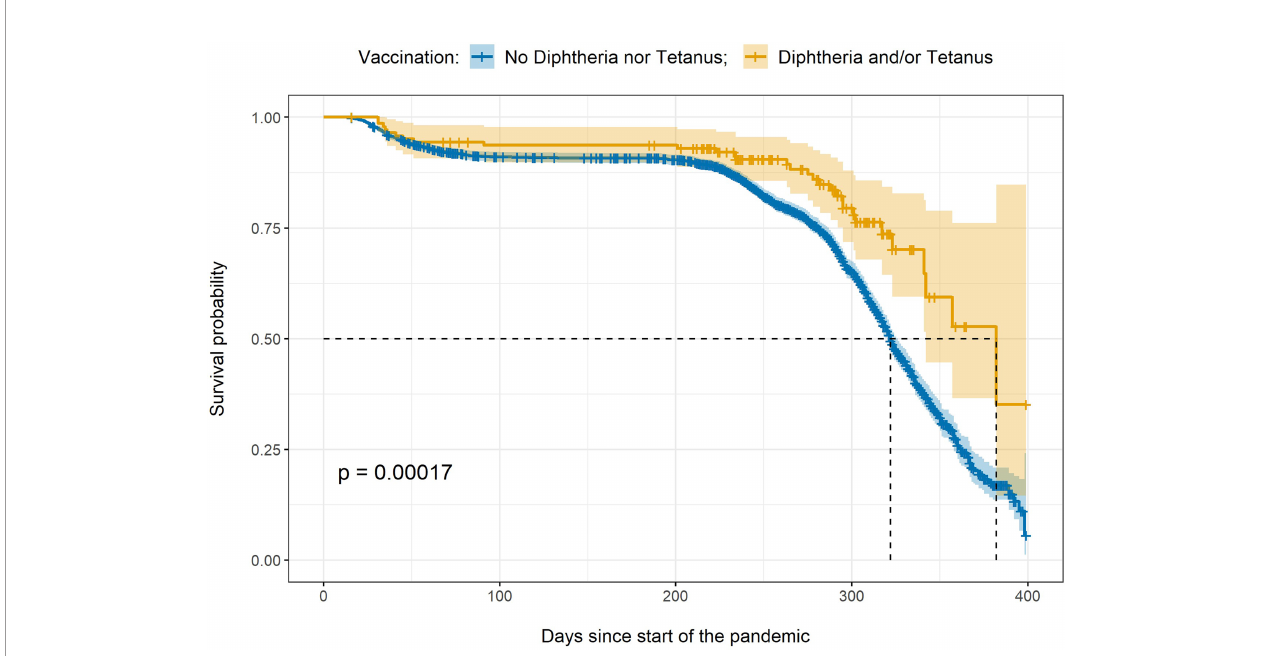
FIGURE 2 | Kaplan Meier curve. The fi gure shows the survival probability over time and con fi dence intervals for two groups: those participants with a vaccination record of diphtheria and/or tetanus (in yellow) versus those participants with no diphtheria or tetanus vaccinations in their records (in blue). The x-axis indicates the number of days since the start of the pandemic in the UK, the y-axis indicates the survival probability. The dotted lines indicate the median survival time for each group. p =